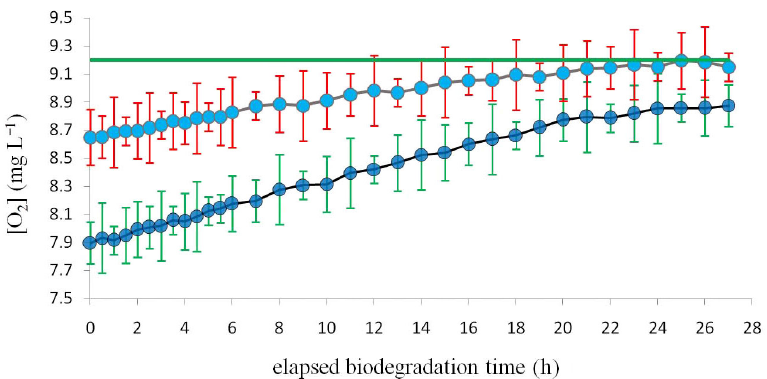
Figure 4. The ordinate: dissolved oxygen [O 2 ] (mg L − 1 ) measured by the two oximeters (15) relative to the biodegradation experiment using an air flow of 10 L min − 1 .The first oximeter is placed on the top of bioreactor (21) and corresponds to the brown line with red error bars; the second oximeter is placed in the sedimentation tank (16) and corresponds to the black line with green error bars. The very top horizontal green straight line represents the asymptotic saturation oxygen concentration value (9.2 mg L − 1 ) at 20 ◦ C. The abscissa: elapsed time (h) during the biodegradation experiment.